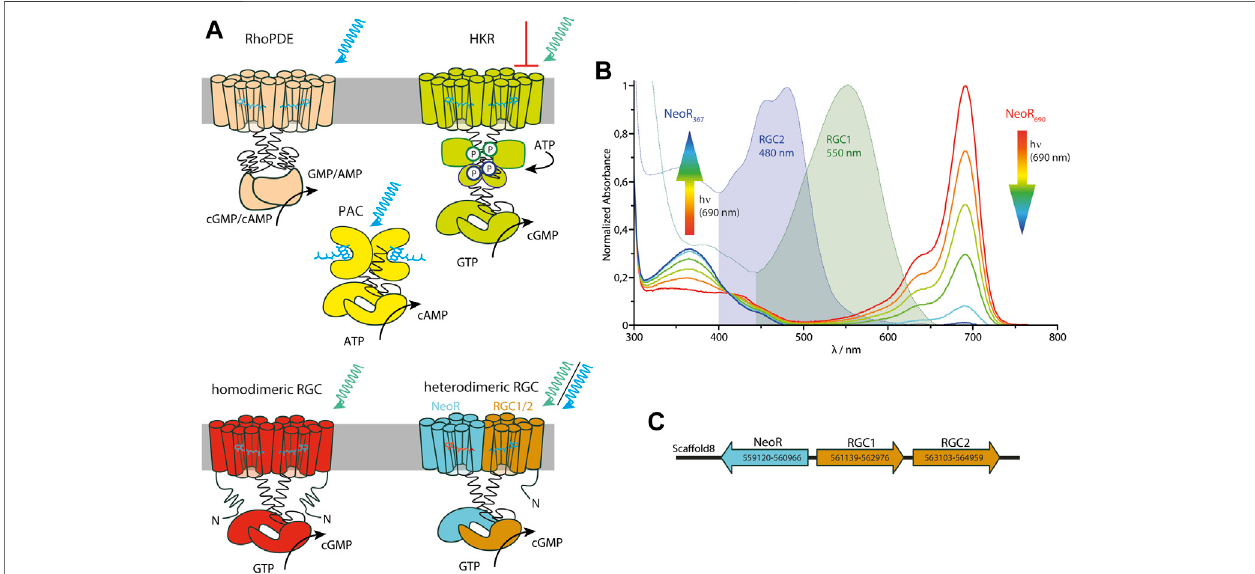
FIGURE 2 | (A) Cartoon of all three types of currently known Enzymerhodopsins: Rhodopsin-Phosphodiesterase (RhoPDE), Histidine-Kinase Rhodopsin (HKR) and homodimeric and heterodimeric Rhodopsin-guanylyl Cyclases (RGC), complemented by soluble photoactivated adenylyl-cyclase (PAC) from bacteria containing a BLUF-photosensor (Stierl et al., 2011). Blue/green-light triggered enzyme activation is indicated by arrows (for HKR green-light inhibits cyclase function). (B) Spectra of thethreeRGCs — RGC1,RGC2,andNeoR — from R.globosum withthetwophotoconvertablestatesofNeoR( λ MAX givenasindices).Therainbow-coloredarrows symbolize the NIR radiation associated with the spectral progression of the bistable photoconversion. (C) Genomic arrangement of RGC-genes in R. globosum . Positions of start- and stop-codons on scaffold 8 from genomic sequencing are given by numbers (Mondo et al., 2017).